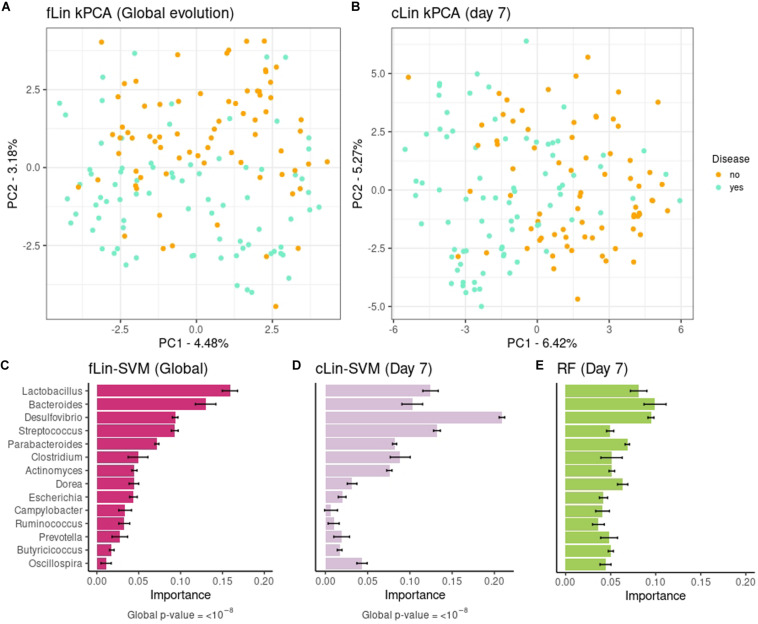
Above: kPCA of fLin in panel (A) and of cLin (day 7) in panel (B). Below: Microbial signatures at the Genera level. Global importance for the first week is in panel (C). Importances for the day 7 according to the cLin kernel and RF are in panels (D,E). Standard error across the 40 replicates is marked with error bars.